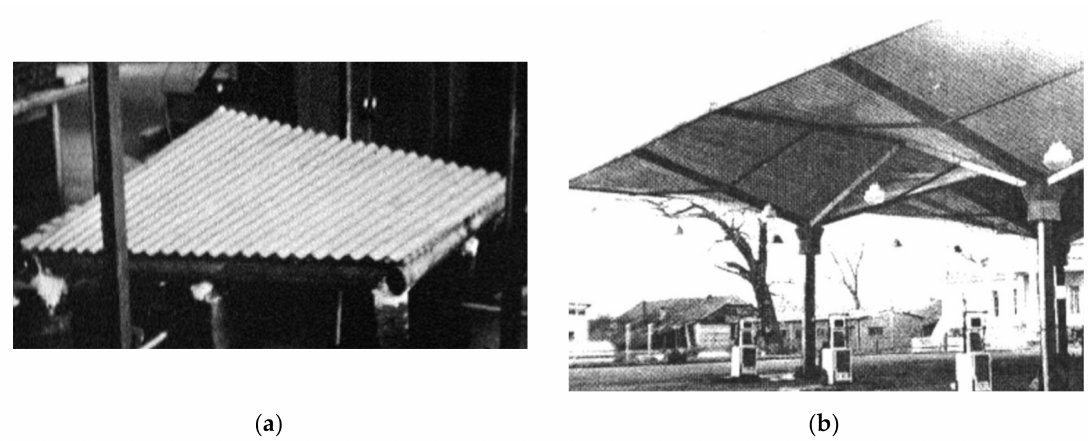
Figure 8. ( a ) The experimental hyperbolic paraboloid shell; ( b ) the erected hyperbolic paraboloid shell structure.